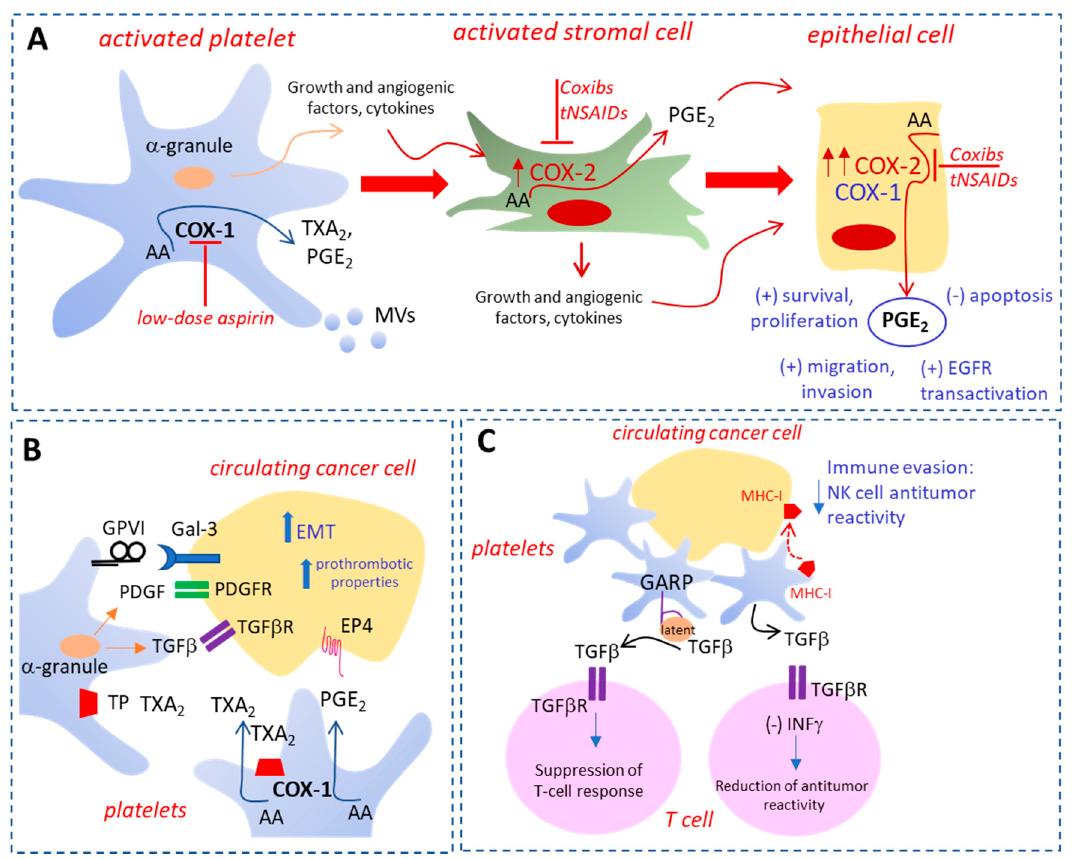
Figure 1. The intimate crosstalk between platelets and cancer. ( A ) In the early phases of colorectal carcinogenesis, activated platelets release soluble factors (including lipids, i.e., PGE 2 and TXA 2 , and proteins, i.e., SDF-1 α , growth and angiogenic factors, cytokines, including interleukin-1 β ) and